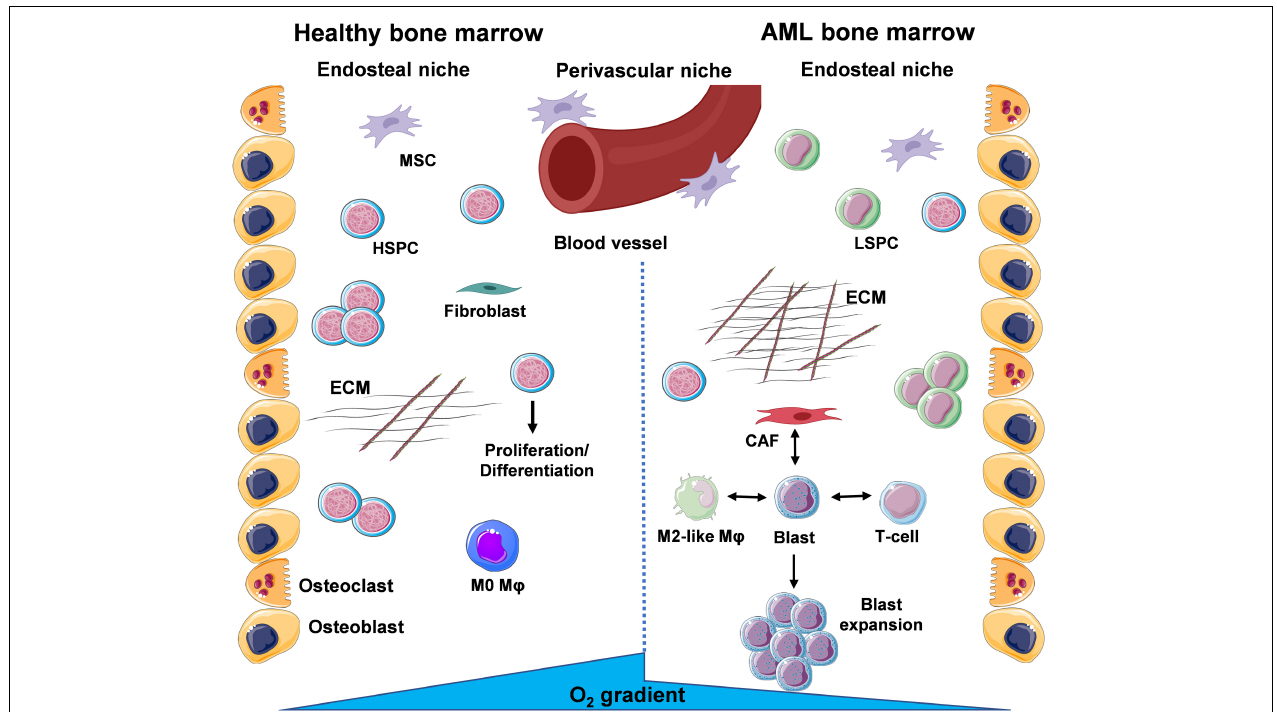
FIGURE 1 | A glance at the bone marrow microenvironment (BMME) in health and in leukaemia. The bone marrow (BM) contains a number of different cell types that coordinate their functions to maintain tissue and whole-body homeostasis and support daily blood production through haematopoietic stem and progenitor cells (HSPCs). These cells exist within specific niches, distinguished by oxygen and nutrient gradients, namely the endosteal/osteoblastic niche, shaped by bone-lining osteoblasts and bone-resorbing osteoclasts, and the perivascular/vascular niche. Under basal conditions, HSPCs will migrate from the endosteal to the perivascular niche where they exit dormancy and enter the cell cycle to divide and differentiate into mature cells of the haematopoietic system. Throughout the BM, deposition of extracellular matrix (ECM) by resident fibroblasts and signalling via mesenchymal stem/stromal cells (MSCs) supports normal function of HSPCs. During AML, the presence of leukaemic stem and progenitor cells (LSPCs) results in expansion of the oxygen and nutrient gradients, creating an environment inhospitable to normal HSPC function. Subsequent expansion of blast populations ensures further optimal conditions for the leukaemic cells via cross-talk with surrounding resident cells. Interactions of leukaemic blasts with γ / δ T-cells (immune suppression), cancer-associated fibroblasts (CAFs) (enhanced ECM deposition and loss of organisation) and M2-like macrophages (M ϕ s) (anti-inflammatory, tumour-promoting) are the focus of a number of studies (created using Servier Medical Art; Created using